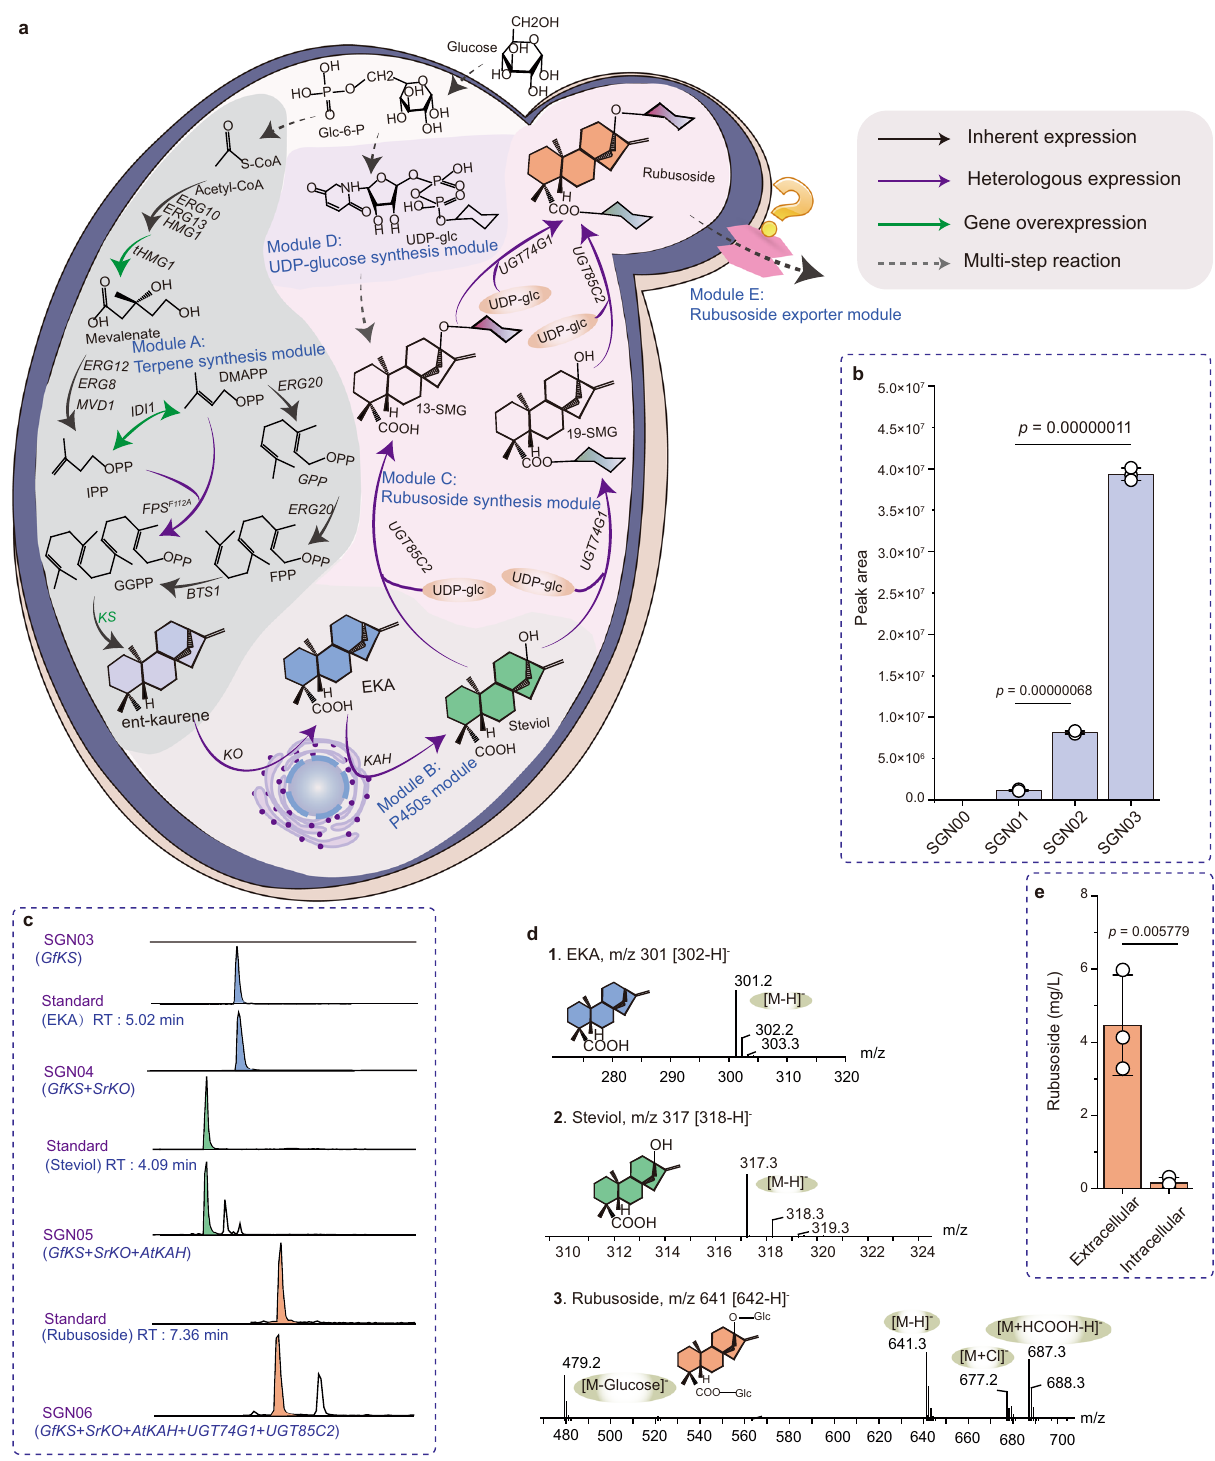
(Supplementary Fig. 5), indicating that synthesizing steviol from EKA is a key rate-limiting step in Module B (Fig. 2a). It is dif fi cult to determine whether KO limits the metabolic fl ux from ent- kaurene to EKA, due to the lack of the commercial ent-kaurene standard. Therefore, to overcome the rate-limiting issues, all the enzymes in Module B were investigated, including the two P450s (KO and KAH) and their reductase (CPR1). First, the individual genes were integrated into SGN05. Compared with SGN05, ste- viol titer increased by 91.3% in CYP-01 (overexpressing KO ),